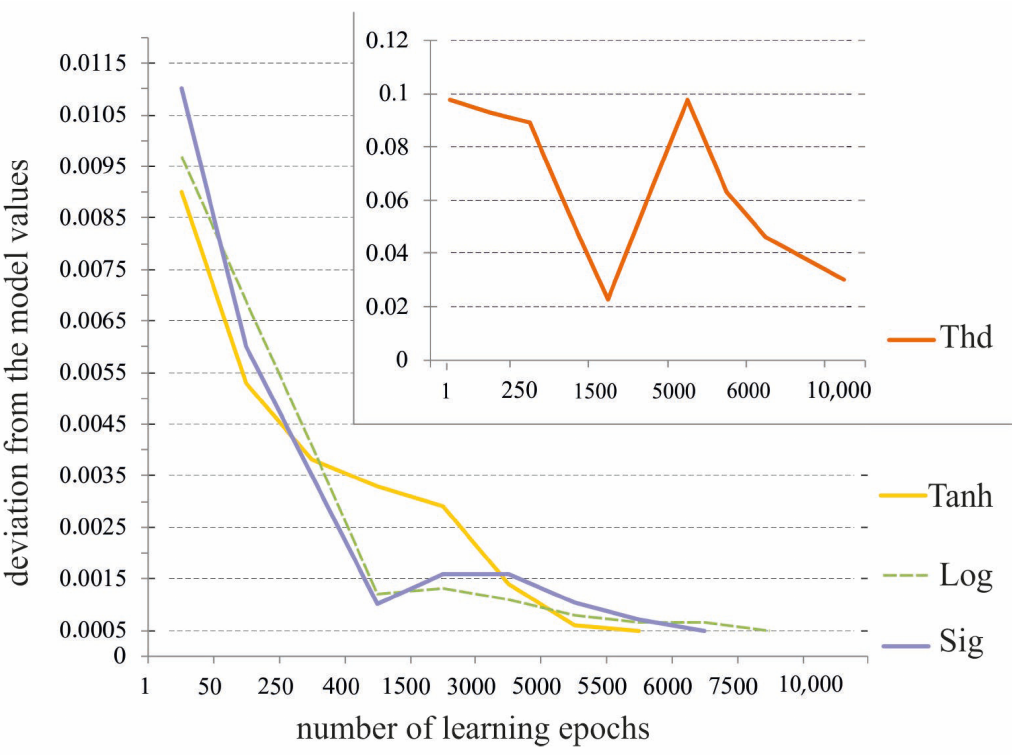
Figure 2. Learning curves of the ANN with different activation functions in the hidden layer of neurons (discussions in the